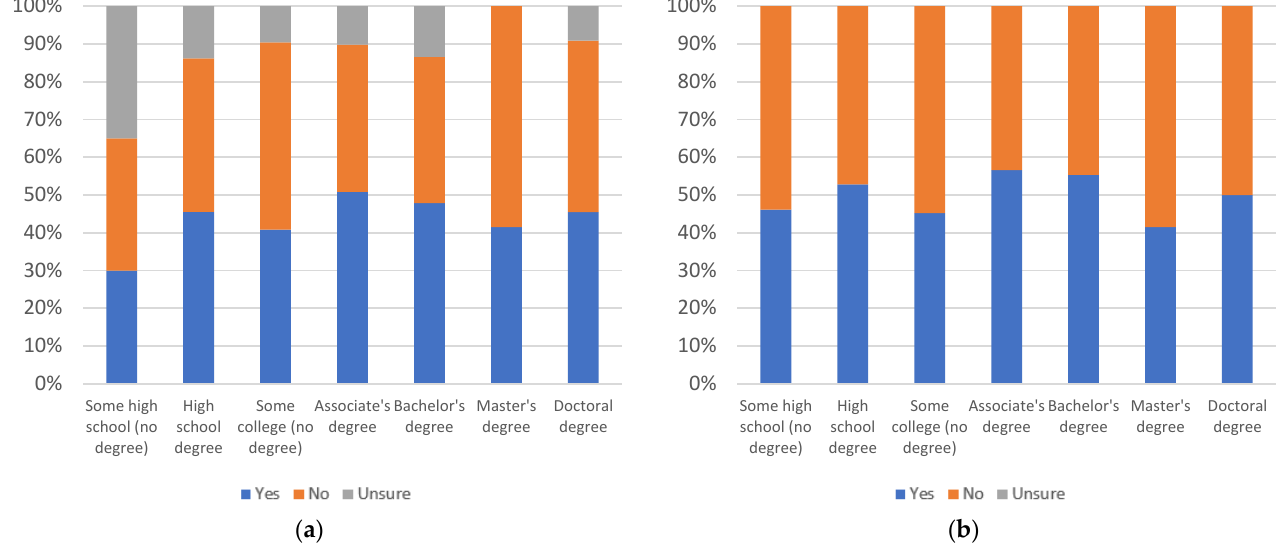
Figure 41. Label annoyingness, by education level: ( a ) with uncertain respondents (left) and ( b ) without uncertain respondents (right).